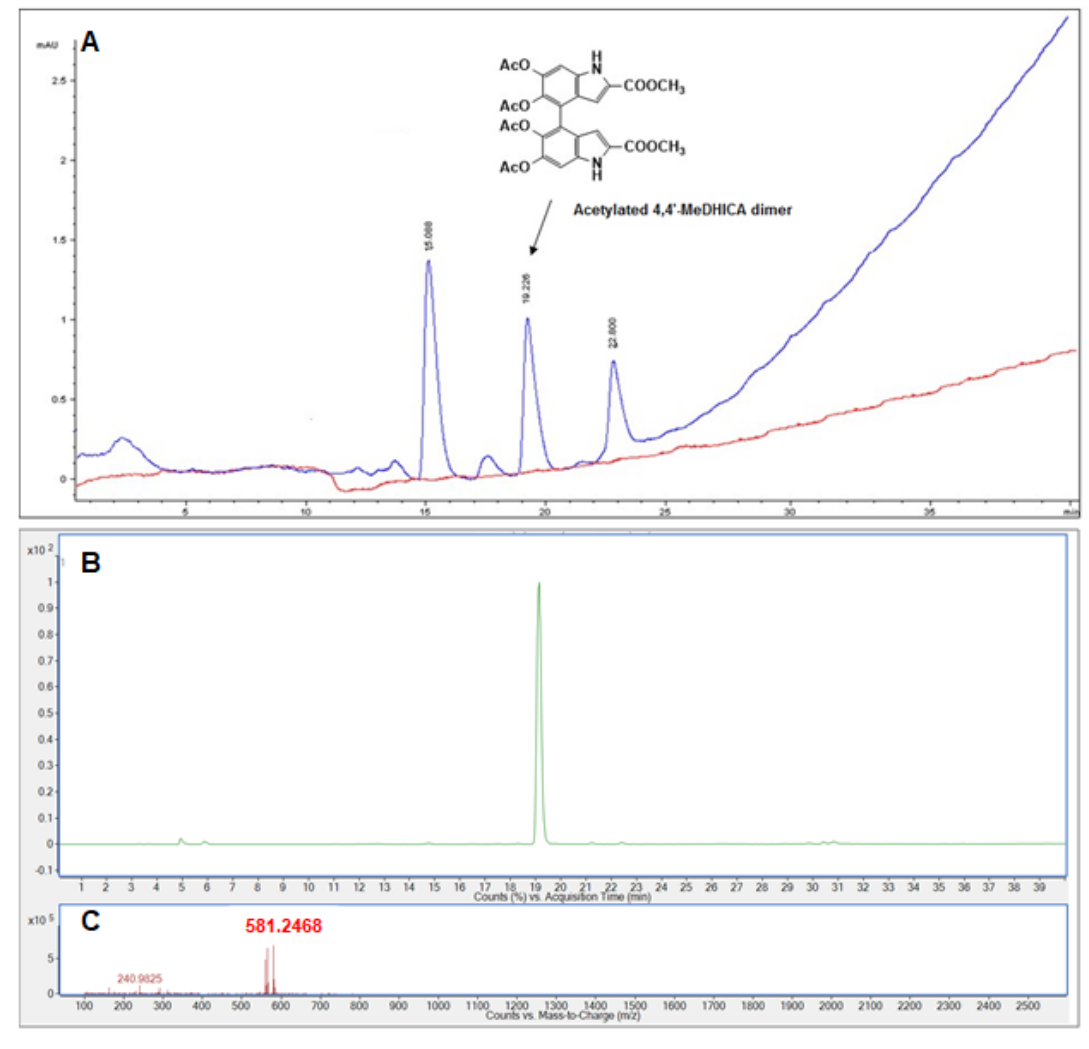
Figure 7. HPLC and LC-MS analysis of cell lysate. ( A ) HPLC profile of acetylated cell lysate (blue trace) and acetylated lysate from control cells (not incubated with MeDHICA-melanin) (red trace). ( B ) LC-MS extracted ion chromatogram ( m / z 581). ( C ) MS spectrum of the compound eluted at 19 min. Supplementary Materials: The following are available online at http: // www.mdpi.com / 2076-3921 / 9 / 4 / 270 / s1, Figure S1: Lipid peroxidation levels evaluated by TBARS